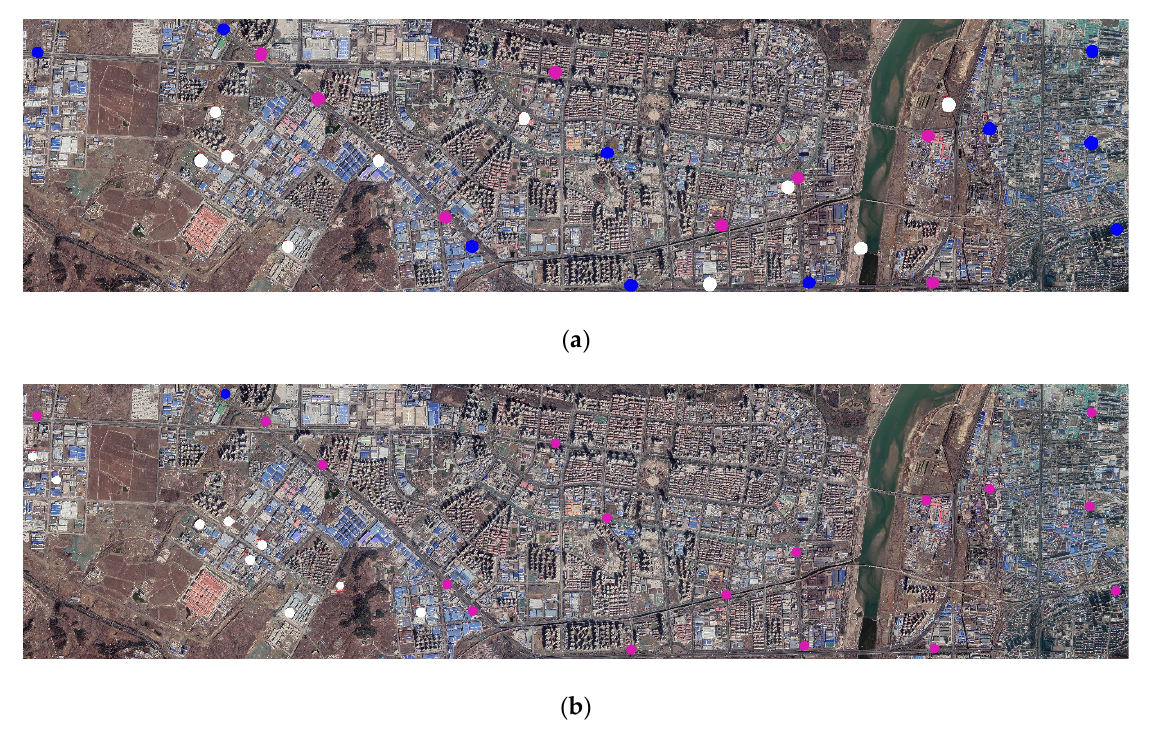
Figure 13. Detection results of gas stations in remote sensing images by YOLO-S-CIOU and YOLOv3. ( a ) is the detection result of YOLO-S-CIOU on Google maps and ( b ) is the detection result of YOLOv3 on Google maps. A blue point in ( a ), ( b ) refers to the true positive (TP); a purple point refers to the false negative (FN); and a white point refers to the false positive (FP).